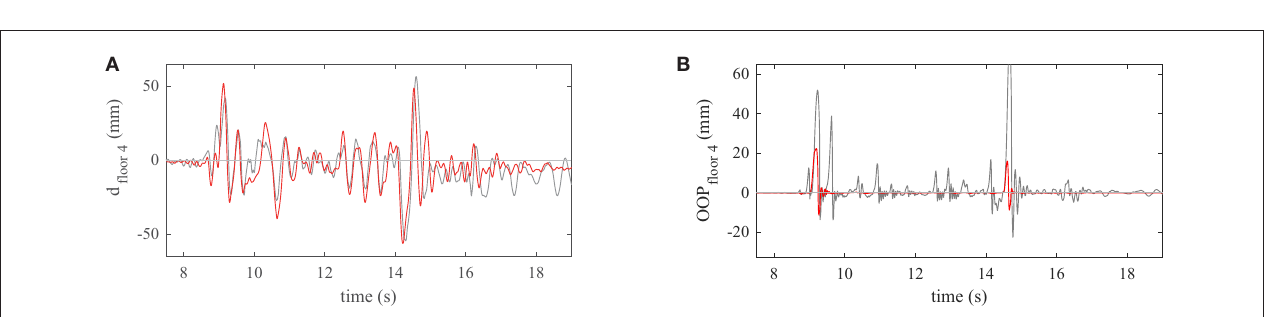
FIGURE 15 | Mixed RC/URM building: comparison of time-history responses for Run 9, for (A) the top floor displacement and (B) the out-of-plane deformation at the top